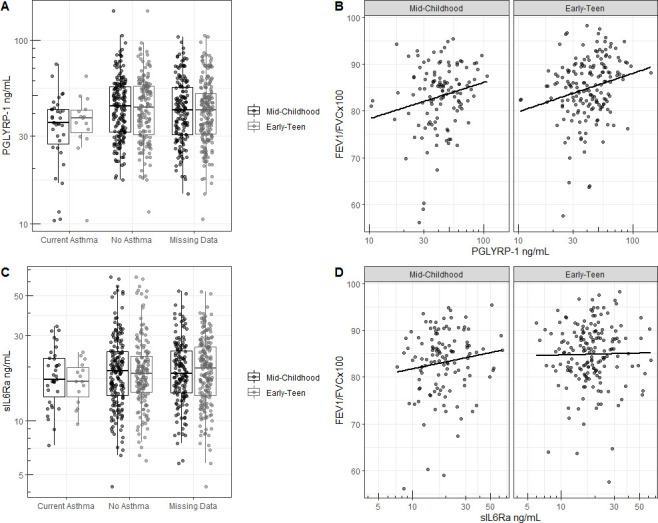
Cord blood serum proteins in relationship to outcomes.(A) PGLYRP-1 concentration in umbilical cord blood serum in relationship to current asthma determined by questionnaire response and (B) FEV1/FVCx100 at mid-childhood and early-teenage follow ups. (C) sIL6Rα concentration in umbilical cord blood serum in relationship to current asthma determined by questionnaire response and (D) FEV1/FVCx100 at mid-childhood and early-teenage follow ups.